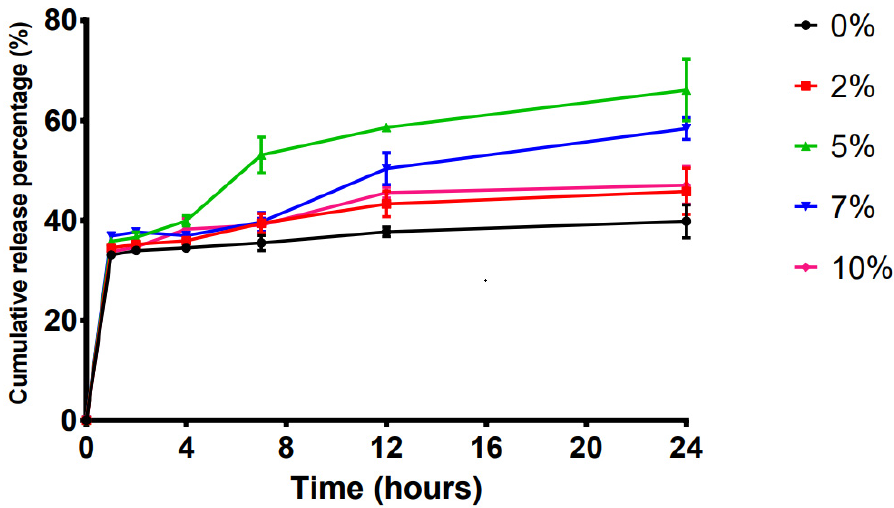
Figure 3. Effect of different concentrations of polyacrylic acid resin II on drug release in the LP-VPH compound transdermal drug delivery system (mean ± SD, n = 3).